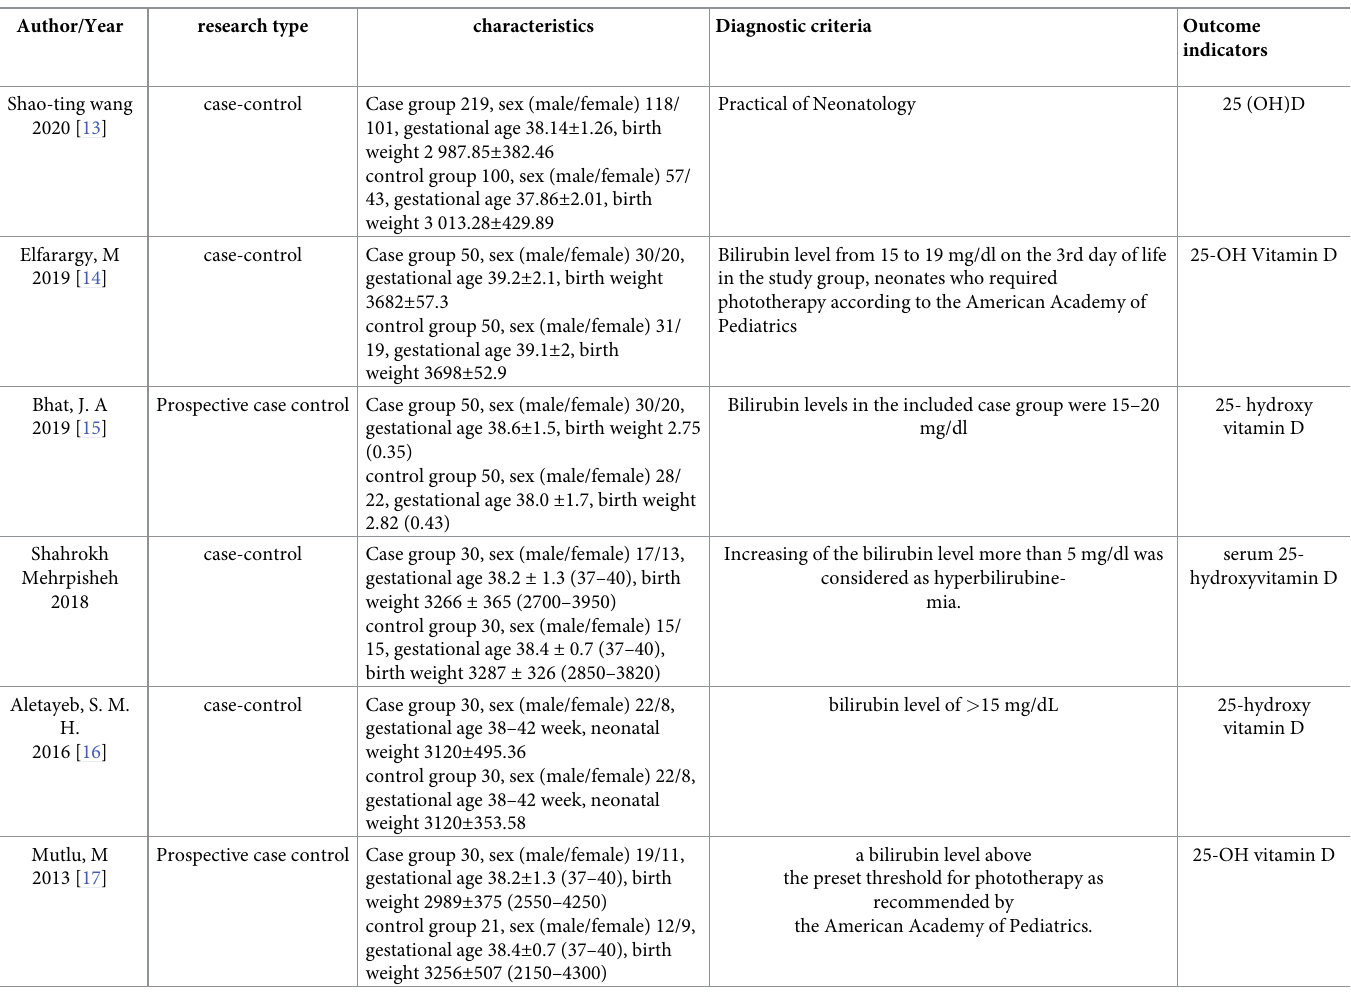
Table 1. Characteristics of the included studies.